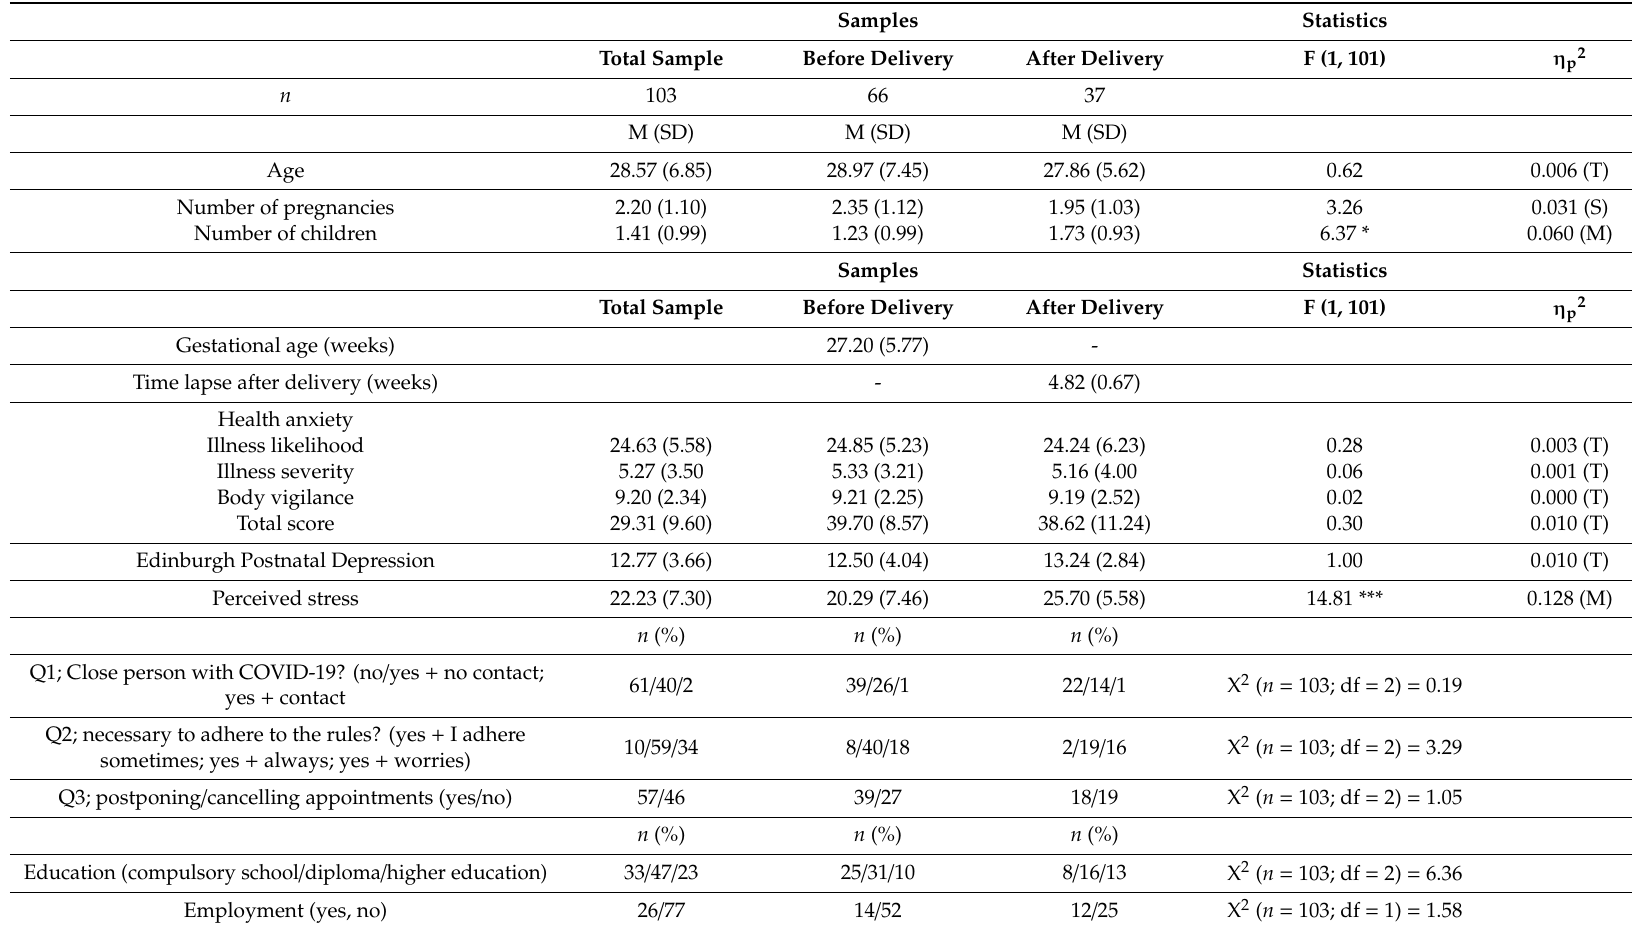
Table 1. Descriptive and inferential statistical overview of sociodemographic, pregnancy-related, and psychological dimensions; the entire sample ( n = 103) and separately for participants before ( n = 66) and after delivery ( n =